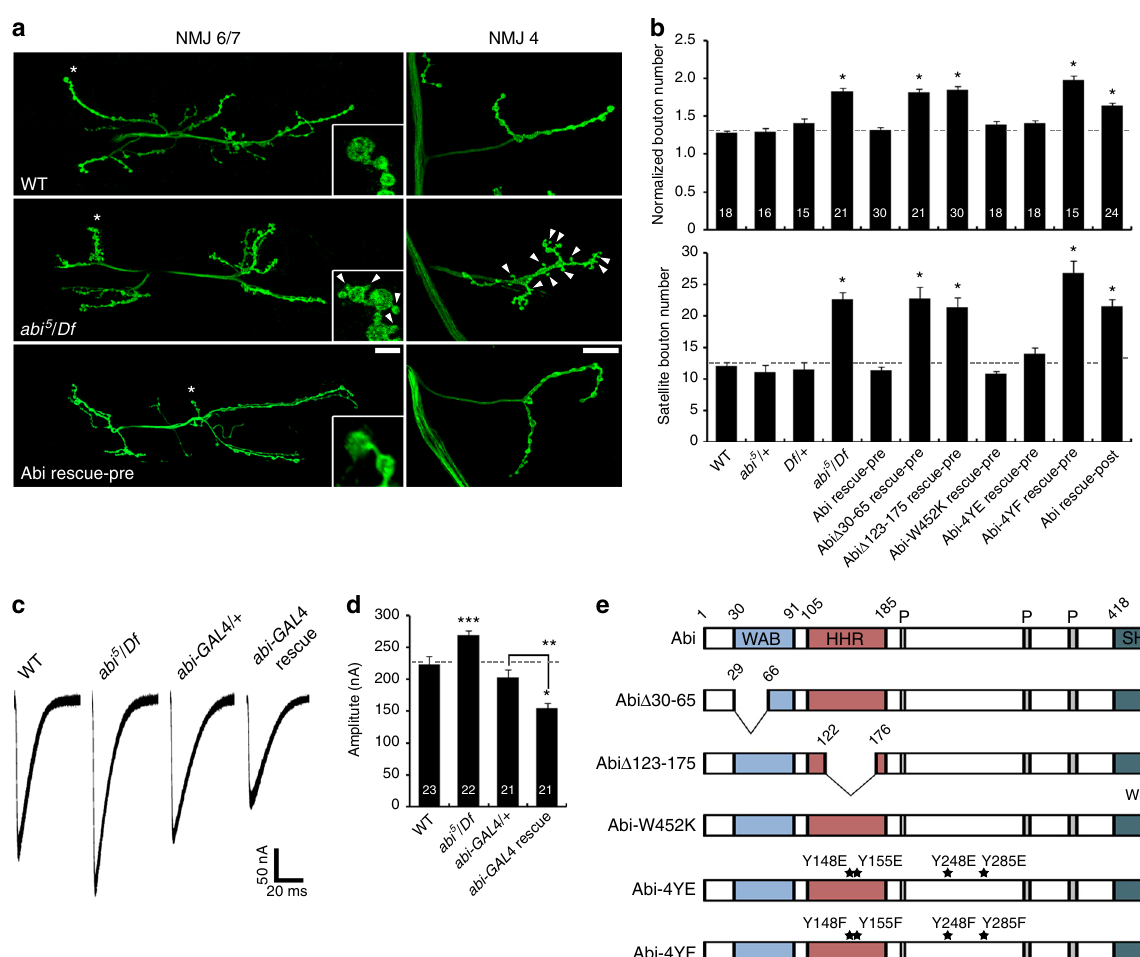
Fig. 2 abi controls synaptic structure and function at the neuromuscular junction (NMJ). a Loss of Abi causes synaptic overgrowth with excessive satellite bouton formation. Sample confocal images of anti-HRP labeled NMJs 6/7 and 4 in wild type, abi 5 / Df , and C155 - GAL4 / + ; UAS - HA - abi , Df / abi 5 (Abi rescue- pre). Insets (left panels) show higher magni fi cation views of boutons marked by white asterisks. Satellite boutons are indicated by arrowheads. Scale bars: 20 μ m. b Quanti fi cation of total bouton number normalized to muscle surface area ([#/ μ m 2 ] × 10 3 ; top) and satellite bouton number (bottom) at NMJ 6/7 in wild type, abi 5 / + , Df / + , abi 5 / Df , C155 - GAL4 / + ; UAS - HA - abi , Df / abi 5 (Abi rescue-pre), C155 - GAL4 / + ; UAS - HA - abi Δ 30 – 65 / + ; abi 5 / Df (Abi Δ 30 – 65 rescue- pre), C155 - GAL4 / + ; UAS - HA - abi Δ 123 – 175 , Df / abi 5 (Abi Δ 123 – 175 rescue-pre), C155 - GAL4 / + ; UAS - HA - abi W452K , Df / abi 5 (Abi-W452K rescue-pre), C155 - GAL4 / + ; UAS - HA - abi 4YE , Df / abi 5 (Abi-4YE rescue-pre), C155 - GAL4 / + ; UAS - HA - abi 4YF , Df / abi 5 (Abi-4YF rescue-pre), 24B - GAL4 , abi 5 / UAS - HA - abi , Df (Abi rescue-post). c , d Loss of Abi causes an increase in NMJ synaptic transmission. c Representative two-electrode voltage-clamp ( − 60 mV) records from muscle 6 with 0.5 Hz nerve stimulation. Sample excitatory junction current (EJC) traces are shown for wild type, abi 5 / Df , abi - GAL4 / + transgenic control, and abi - GAL4 / + ; UAS - HA - abi , Df / abi 5 ( abi - GAL4 rescue). d Quanti fi cation of EJC amplitude. e Schematic view of the domain structure of wild-type Abi and Abi variants used in rescue experiments. WAB, WAVE-binding domain; HHR, homeodomain homologous region; P, proline-rich region; SH3, Src homology 3 domain. Point mutations are indicated by stars. Bar graphs show mean ± s.e.m. Sample number analyzed is indicated inside bars. Statistical analyses were performed by one-way analysis of variance with Tukey – Kramer post hoc test. Comparisons are with wild type (* P < 0.001; ** P < 0.01; *** P <